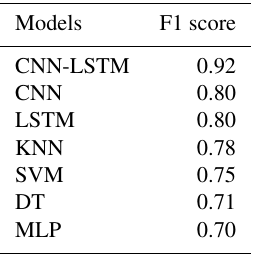
Table 11. Test F1 scores for the developed deep learning and ma- chine learning